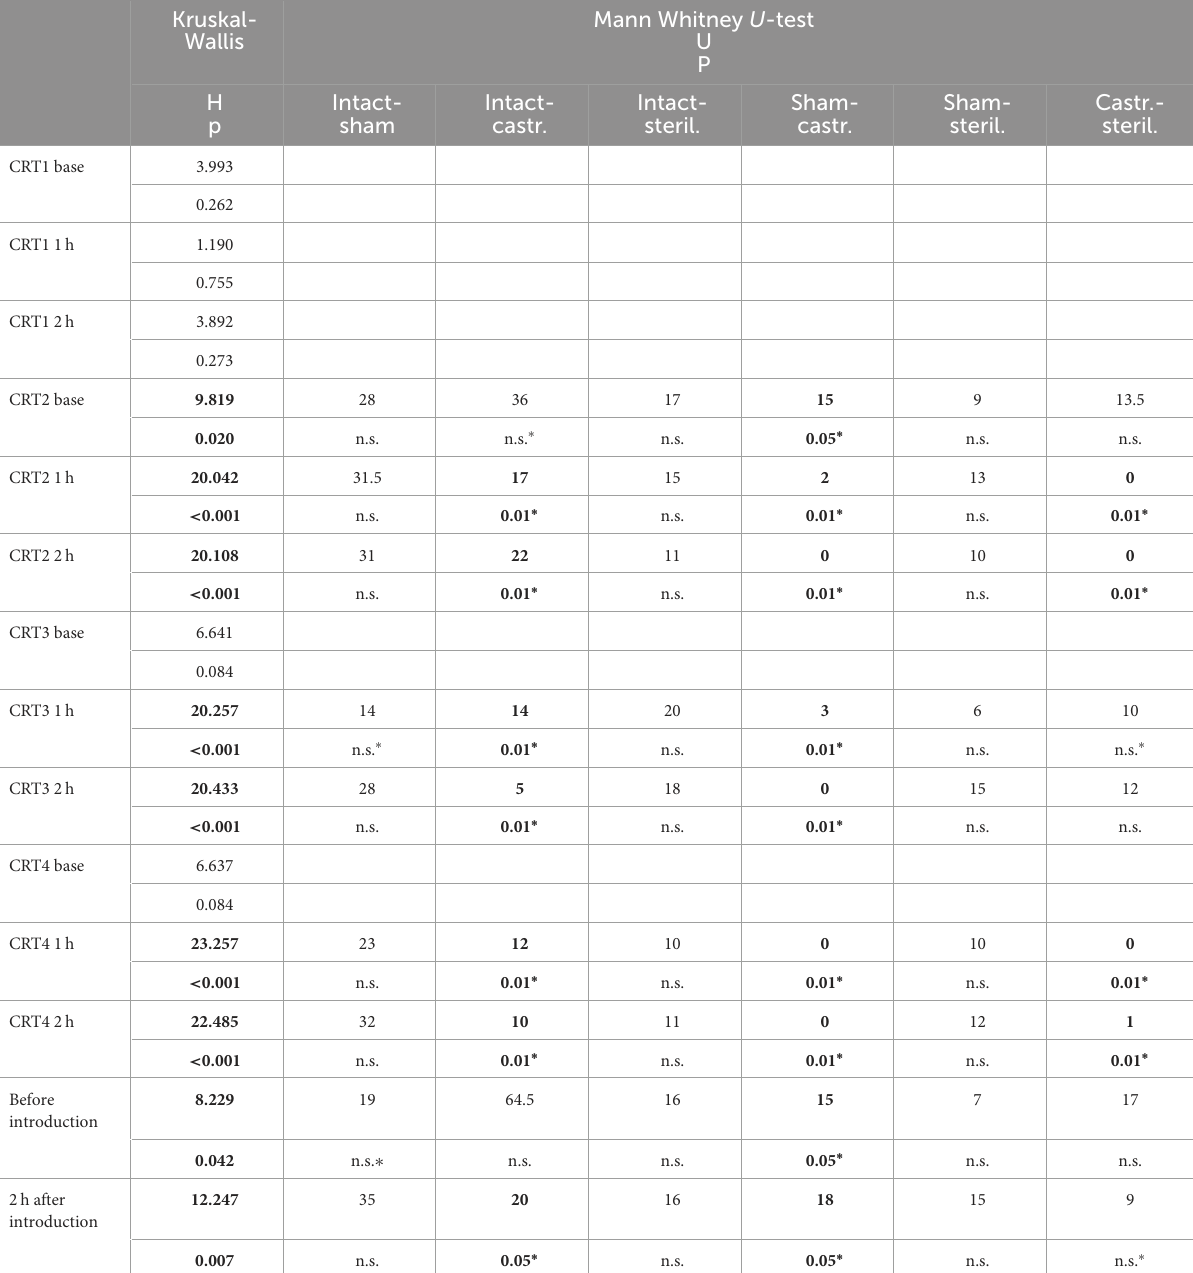
TABLE 2 Statistical parameters of cortisol concentrations of intact ( n = 10), sham-operated ( n = 8), castrated ( n = 14), and sterilized ( n = 4) males. Kruskal-